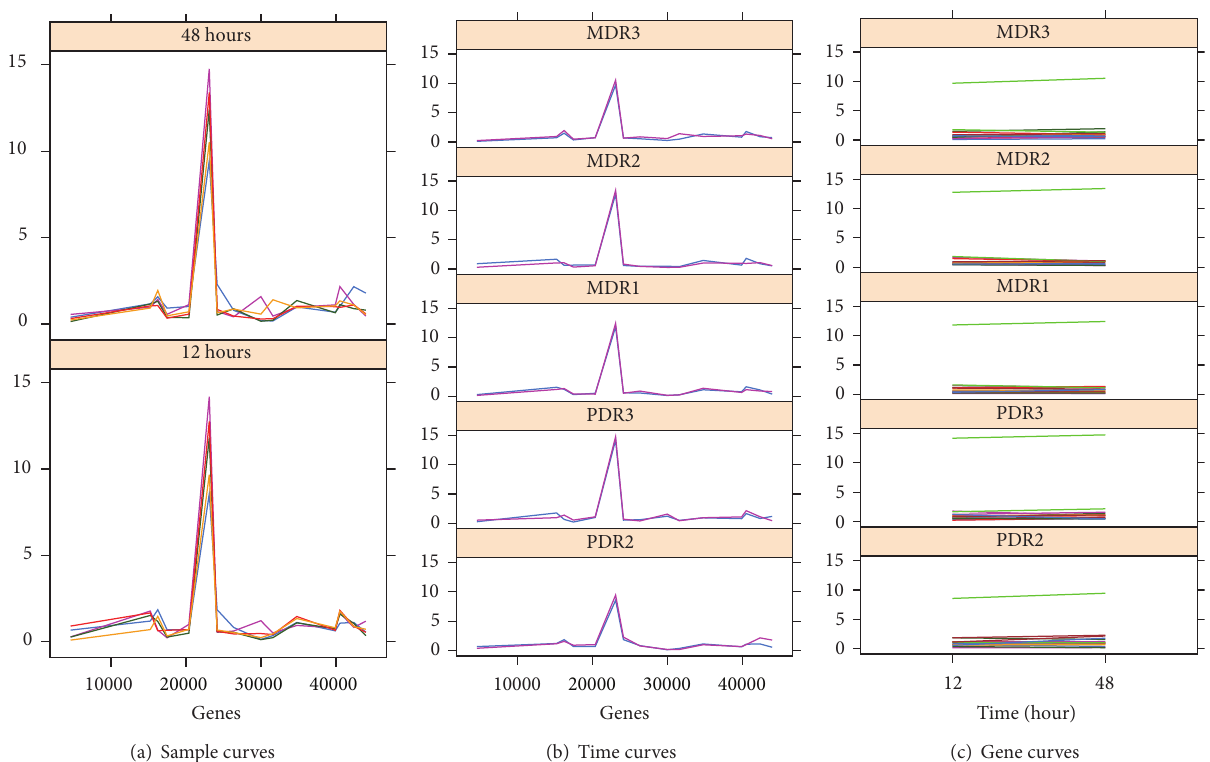
Figure 9: Graphical representation for TC 15 found in the Mouse GSD4442 Dataset.